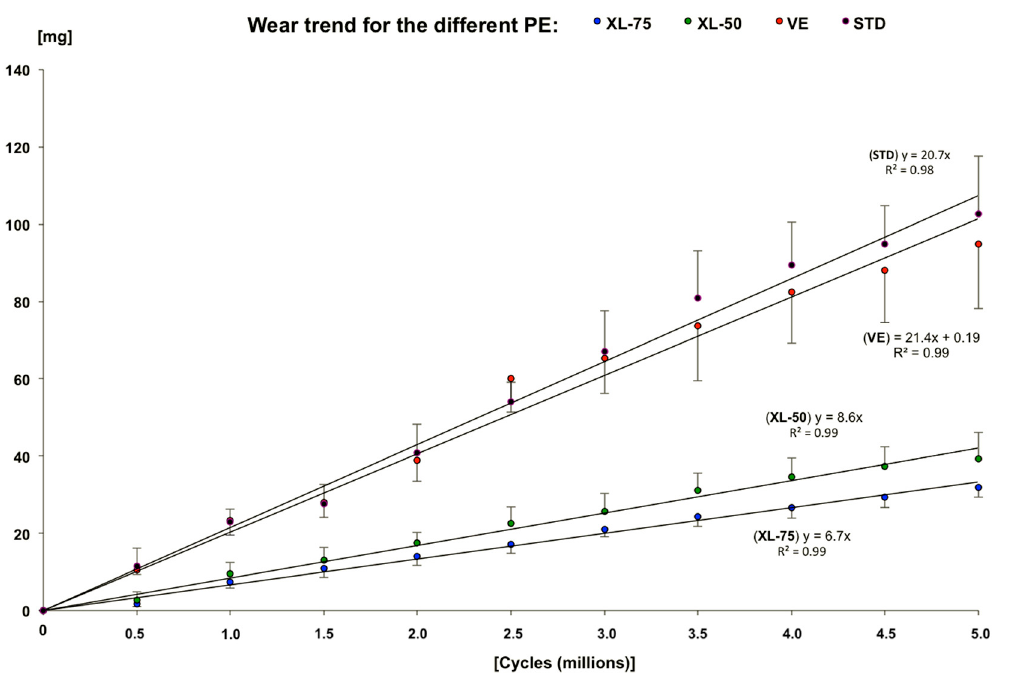
Figure 2. Wear behavior for the different configurations of polyethylene tested.